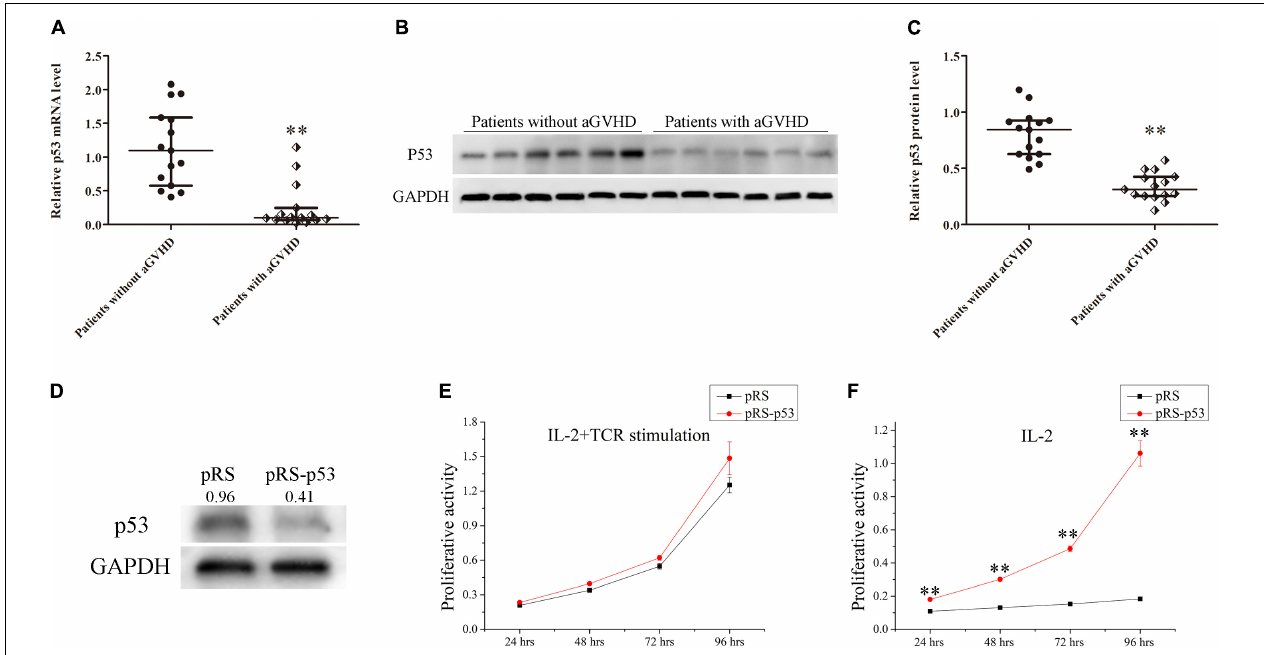
FIGURE 1 | Expression levels of p53 in CD4 + T cells from patients with aGVHD and individuals without aGVHD. (A) Relative mRNA levels of p53 in CD4 + T cells from patients with aGVHD ( n = 15) and the non-aGVHD group ( n = 15) normalized to GAPDH expression. (B) Representative Western blot results for p53 protein expression in CD4 + T cells from patients with aGVHD and those without aGVHD. (C) Quantitative analysis of band intensities for p53 protein levels normalized to GAPDH expression ( n = 15 per group). (D) Representative Western blotting results showing p53 protein levels in normal CD4 + T cells transfected with the p53 interference (pRS-p53) or negative control (pRS) plasmid. (E,F) Determination of the proliferation of p53-deficient CD4 + T cells after stimulation with IL-2 in the presence or absence of anti-CD3/CD28 antibodies. Data are mean ± SD from three independent experiments. ( ∗∗ P < 0.01).